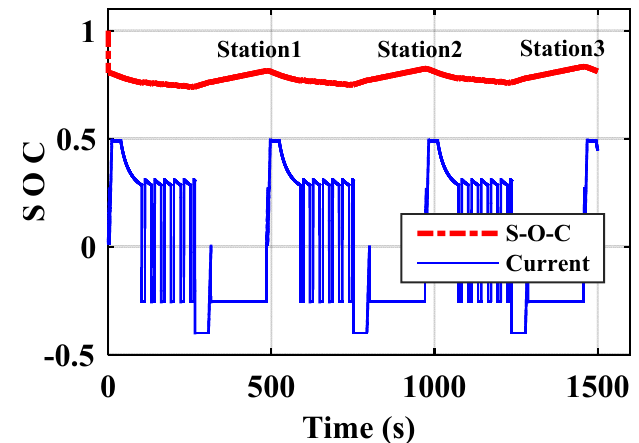
Figure 16. Battery pack’s state of charge with actual load profile scaled (sized for five times of maximum load).